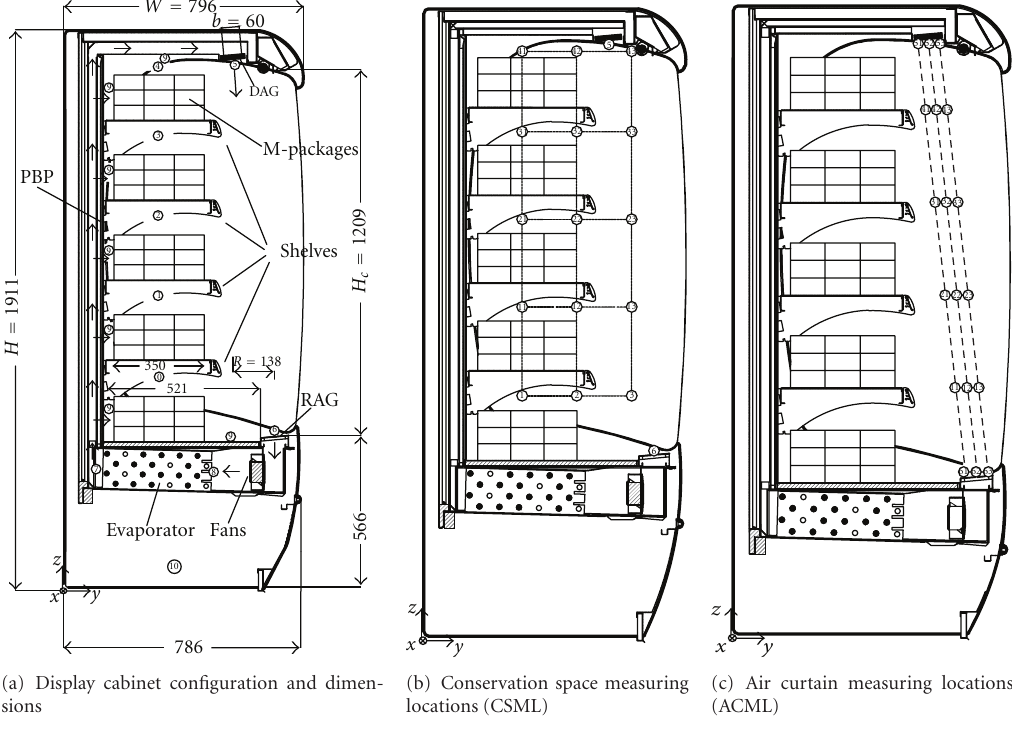
Figure 1: Configuration of open vertical refrigerated display cabinet and measuring probes locations.